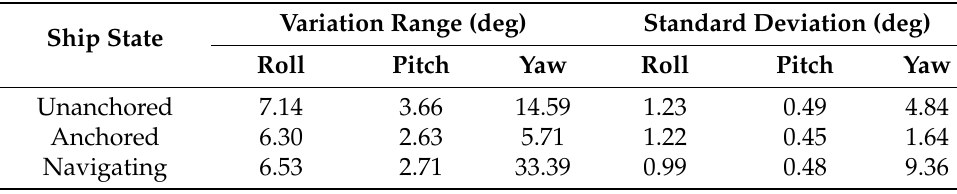
Table 7. Ship attitude angles comparison in different states.